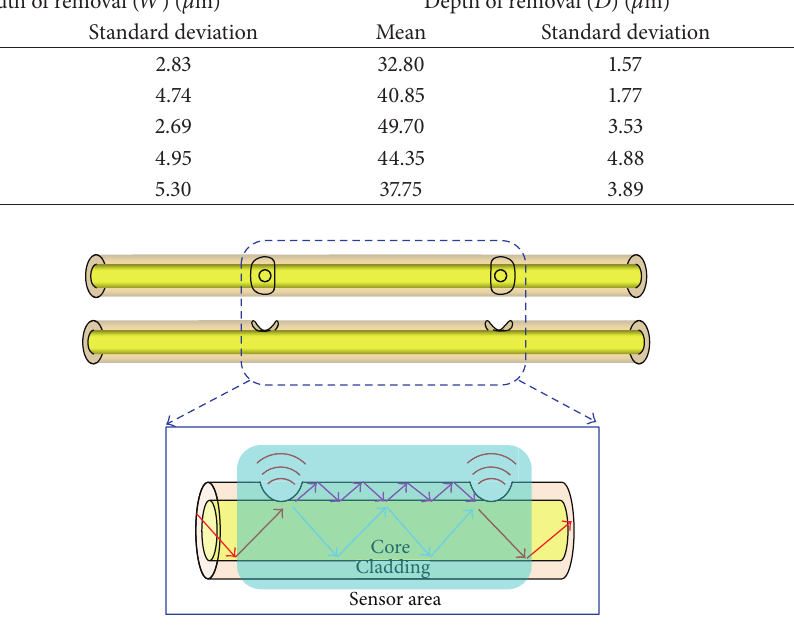
Figure 7: Structures of the FO-MZI sensor for refractive index detection.